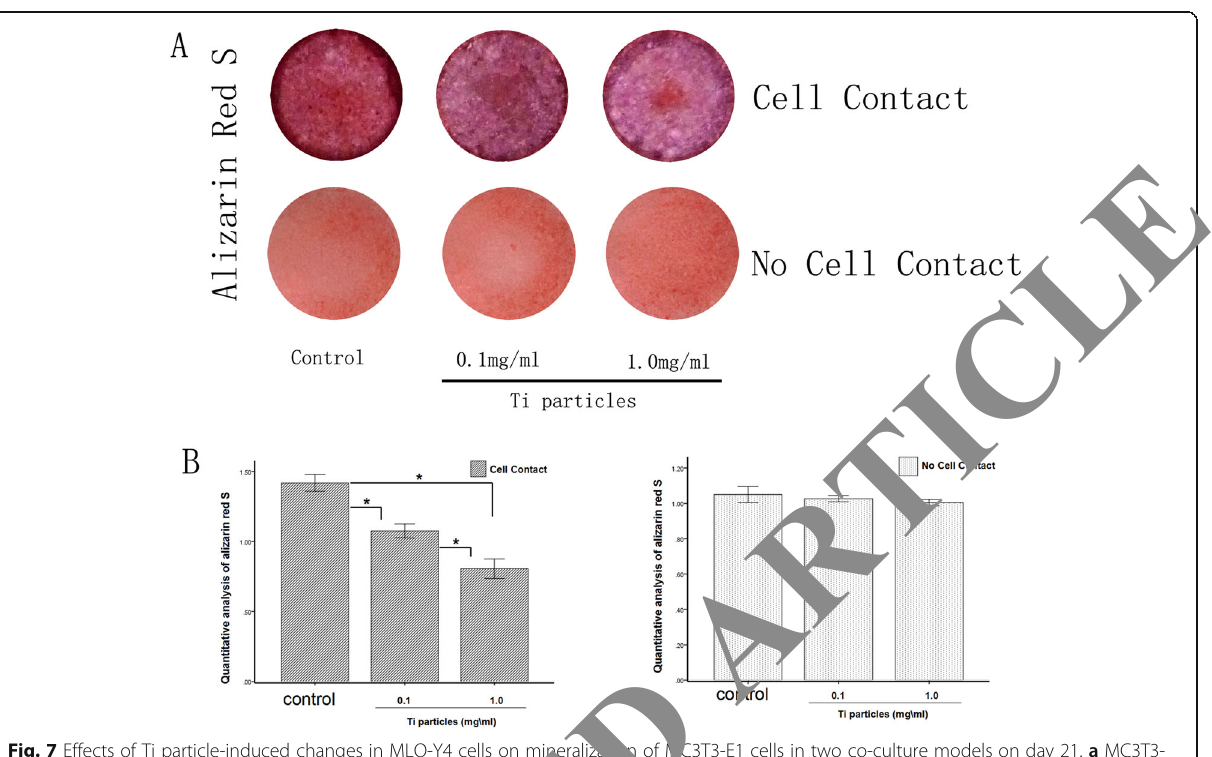
Fig. 7 Effects of Ti particle-induced changes in MLO-Y4 cells on mineralization of MC3T3-E1 cells in two co-culture models on day 21. a MC3T3- E1 cells were stained with alizarin red S. In the “ Cell Contact ” model, the number of mineralized nodulessignificantly decreased as the concentration of Ti particles increased. The number of mineralized nodules in the “ No Cell Contact ” model did not differ significantly from the control. b In the “ Cell Contact ” model, quantitative results of alizarin red differed significantly between the 0.1 mg/mL and 1.0 mg/mL groups and the control (* p < 0.05). In the “ No Cell Contact ” model, no significant differences in Ca 2+ levels were observed in any